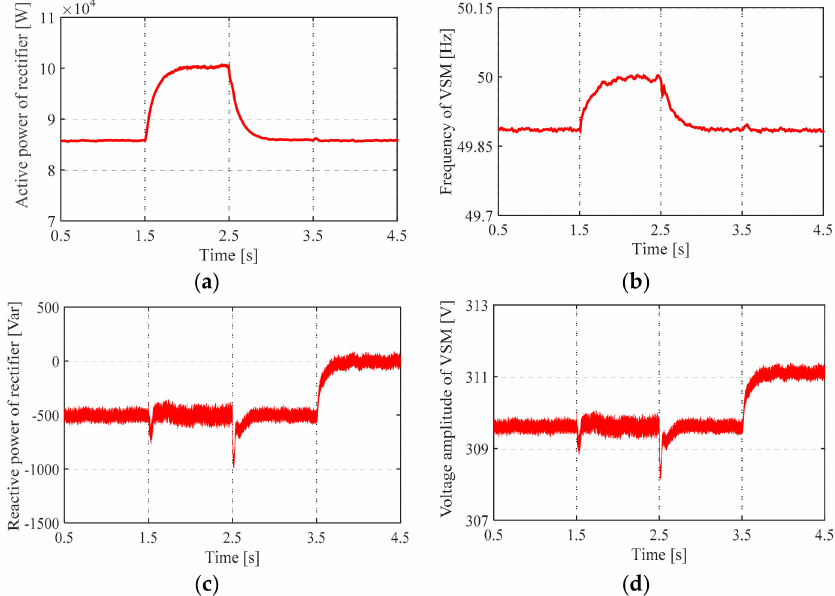
Figure 9. Primary regulation of VSM ( a ) Active power of the rectifier; ( b ) Frequency of VSM; ( c ) Reactive power of the rectifier; ( d ) Voltage amplitude of VSM.